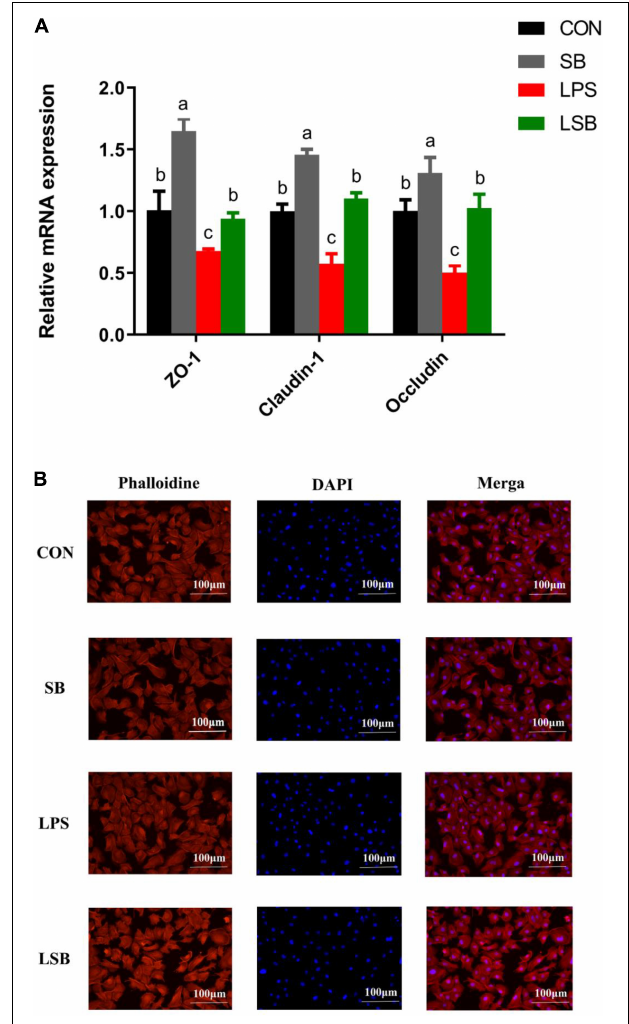
FIGURE 3 | Effects of pretreatment with SB on the expression of genes related to tight junction proteins and cellular morphology in BRECs stimulated with LPS. BRECs were pretreated with SB (0.5 mM) for 18 h followed by stimulation with LPS for 6 h. (A) The gene expression of ZO-1, Claudin-1, and Occludin was analyzed by qRT-PCR. (B) Rhodamine phalloidine staining of BRECs. The values are shown as mean ± SEM ( n = 3). The letters in superscript indicate that the difference between groups was significant ( P <